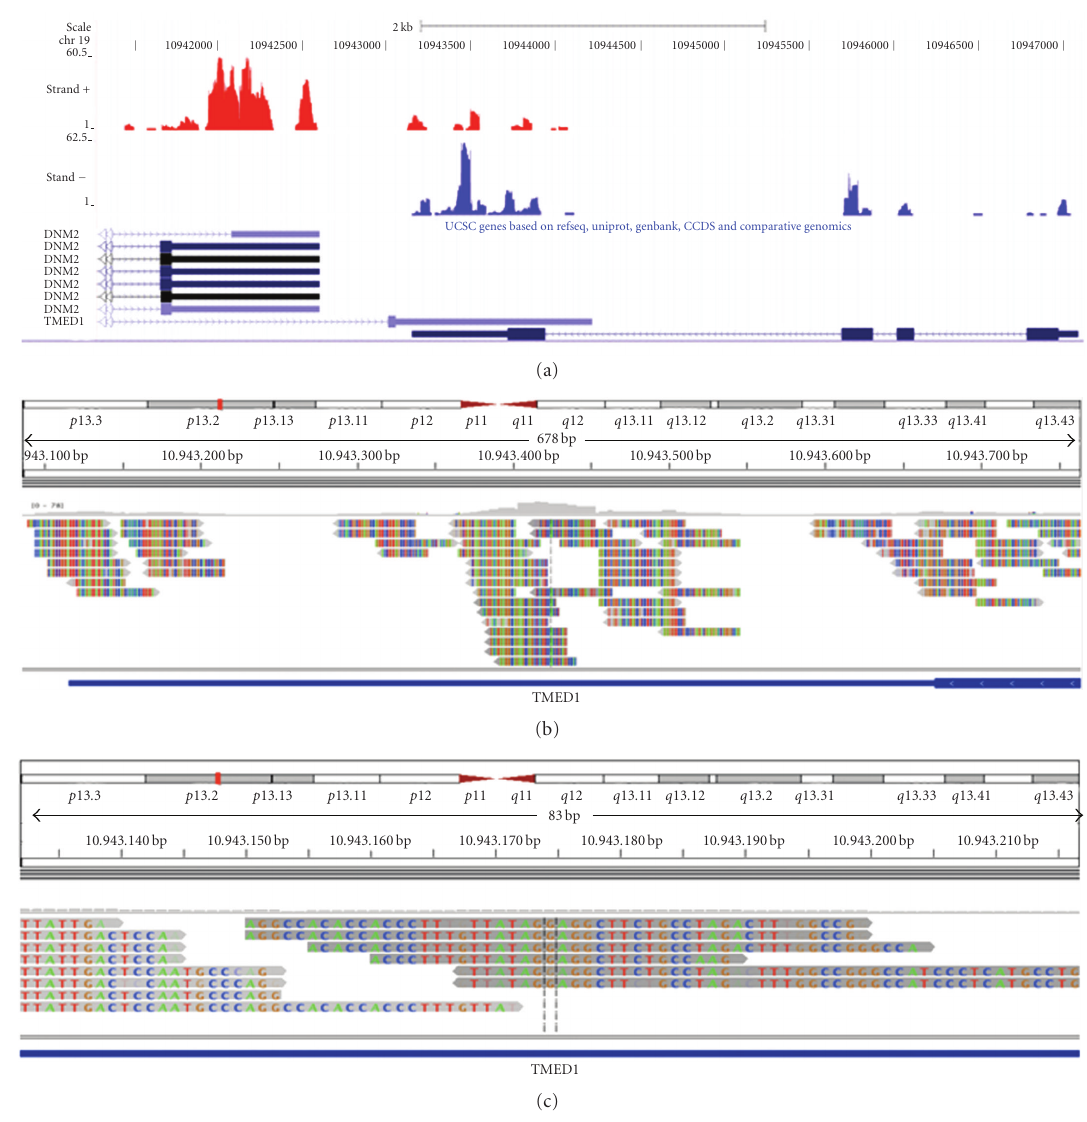
Figure 4: Strand-Specific Read Distribution in UCSC Genome Browser and IGV. (a) UCSC Genome Browser showing an example of stranded sequences generated by RNA-Seq experiment on NGS platform. In particular, the screenshot—of a characteristic “tail to tail” orientation of two human genes—clearly shows the specific expression in both strands where these two genes overlap, indicating that the strandedness of reads is preserved. (b) The same genomic location in the IGV browser, showing the reads (coloured blocks) distribution along TMED1 gene. The grey arrows indicate the sense of transcription. The specific expression in both strands where the genes overlap, indicates that the strandedness of reads is preserved. In (c) a greater magnification of the reads mapping to the same region at nucleotide level, useful to SNP analysis. The chromosome positions are shown at the top and genomic loci of the genes are shown at the bottom of each